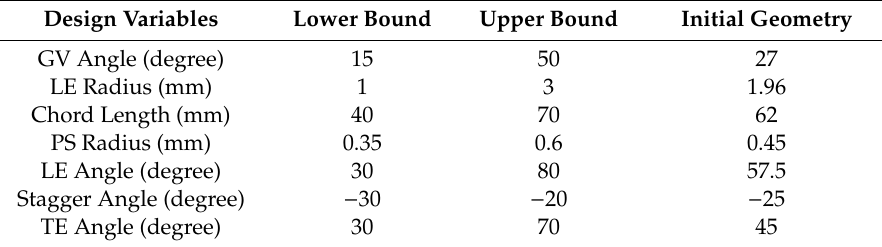
Table 2. Design variables with upper and lower